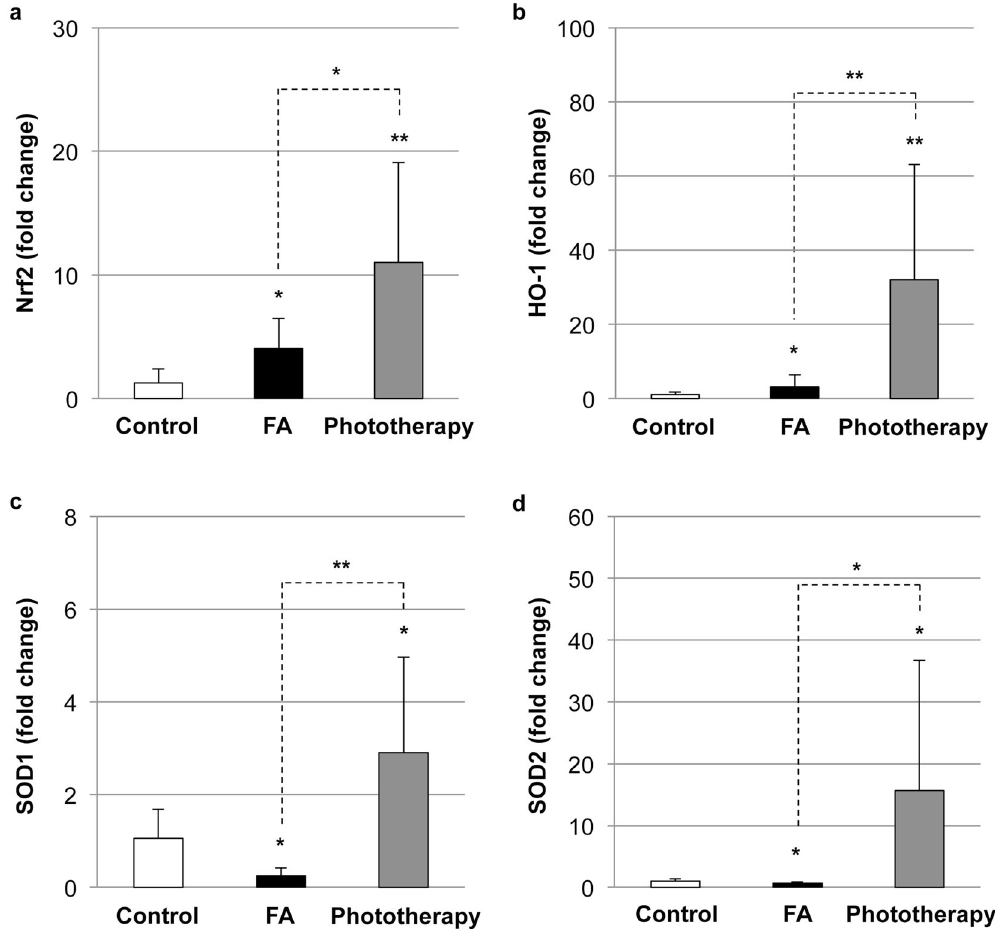
Fig. 5 Impact of phototherapy on oxidative stress and antioxidant defense in food allergy (FA). Intestinal levels of nuclear factor erythroid 2-related factor 2 (Nrf2) ( a ), heme oxygenase-1 (HO-1) ( b ), superoxide dismutase 1 (SOD1) ( c ), and SOD2 ( d ) were evaluated by quantitative real-time PCR. Values are presented as the mean ± SD of at least eight individuals in each group. *, **, P < 0.05 and 0.01 vs. the control or phototherapy group, respectively (Student ’ s t